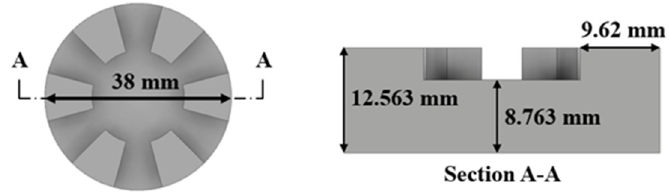
Figure 14. The grinding tool-like forging shape [26].